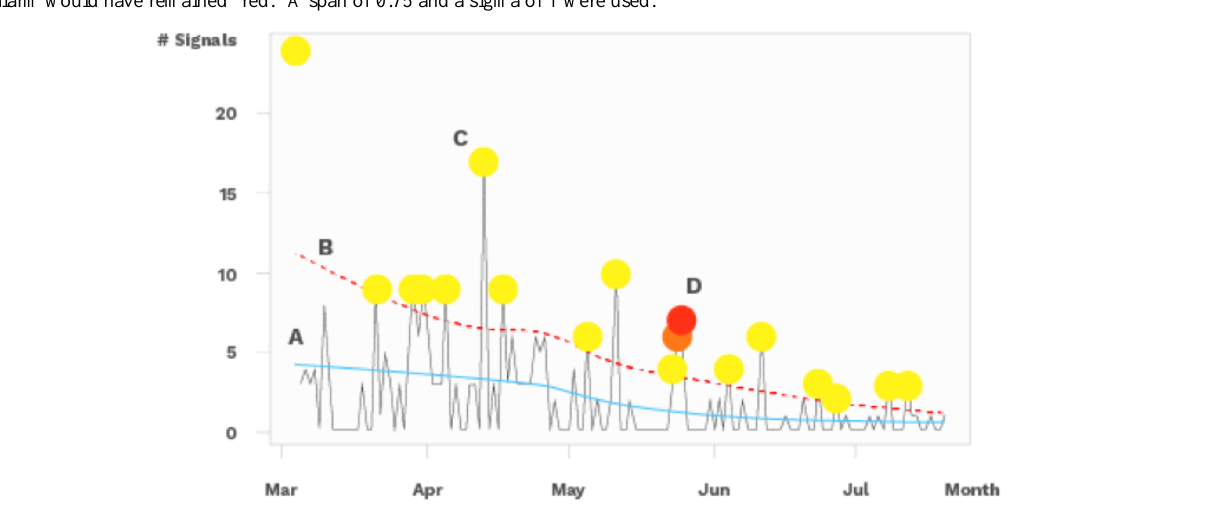
Figure 1. Prototype output implementation of the warning system used in the dashboard of the Guardians of Health platform. The line in blue (A) represents the locally estimated scatterplot smoothing (loess) function with a certain window; this value is known as "span" and controls the smoothness. If it is 1, the line will almost equal the mean value of the series; if it is close to zero, each point will be interpolated by the function. Thus, the function is adjusted by varying this parameter between 0 and 1. The dotted line in red (B) represents the upper range of the loess function; this amplitude was obtained by multiplying the SD by a sigma. Thus, the variability of the series decreases, which makes the interval closer to the loess function.In the event of the graduation of alerts, C indicates one of the points where the value was exceeded, but only at a moment in time which causes that point to generate a "yellow" signal. At D, the observed values exceeded the upper limit three times, the first time generating a "yellow" alert, the second time an "orange" alert, and finally a "red" alert. Then the number of cases fell below the limit and no more alarms were triggered. If this high value persisted, the alarm would have remained "red." A span of 0.75 and a sigma of 1 were